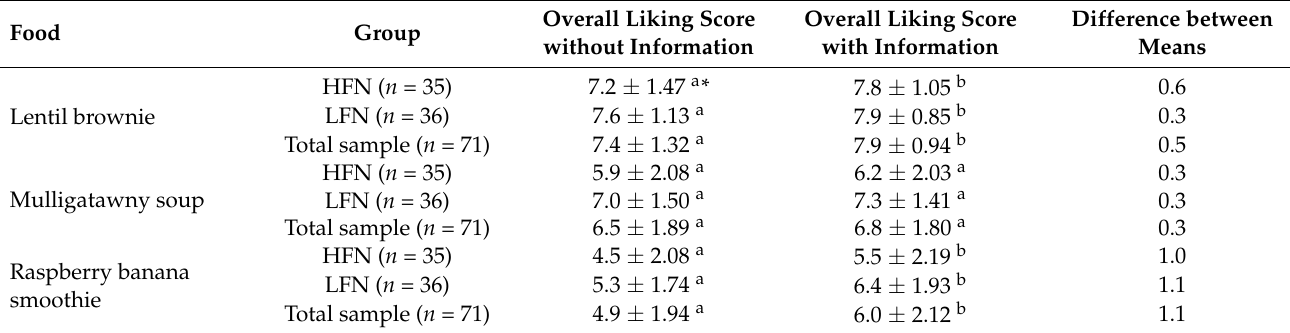
Figure 3. Means and standard deviations for overall liking of ten nutrient-dense foods between food neophobia subgroups without health and nutrition information. Y-axis represents the 9-point hedonic scale (1 = dislike extremely, 5 = neither like nor dislike, 9 = like extremely). For each food, values with different letters are significantly different ( p < 0.05). n = 34 for cheese and spinach quiche and tomato cream cheese and wild rice soup in high food neophobia group due to missing data. Table 5. Food neophobia subgroup differences on mean overall liking with and without information on nutrient-dense ingredients and health benefits for three foods. A 9-point hedonic scale was used (1 = dislike extremely, 5 = neither like nor dislike, 9 = like